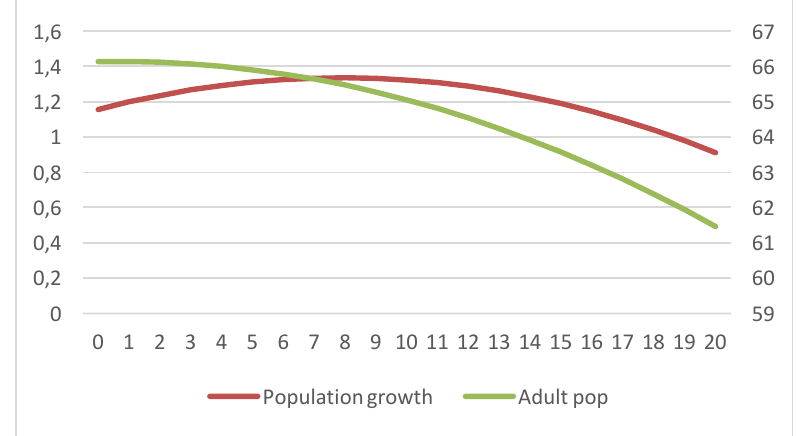
Fig. 6 . The demographic trends in the model (valid for all